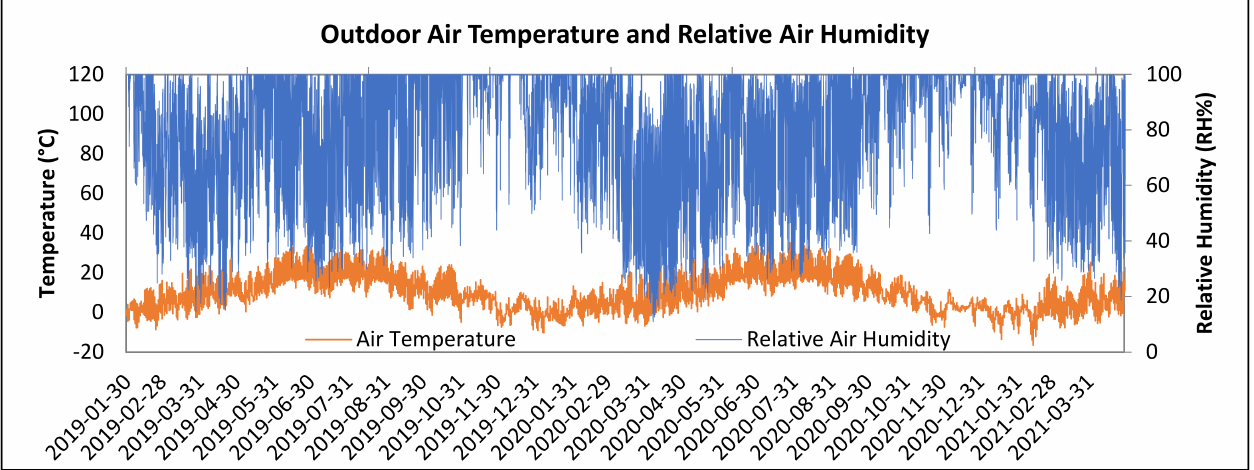
Figure 5. Outdoor Air Temperature and Relative Air Humidity during the Recorded